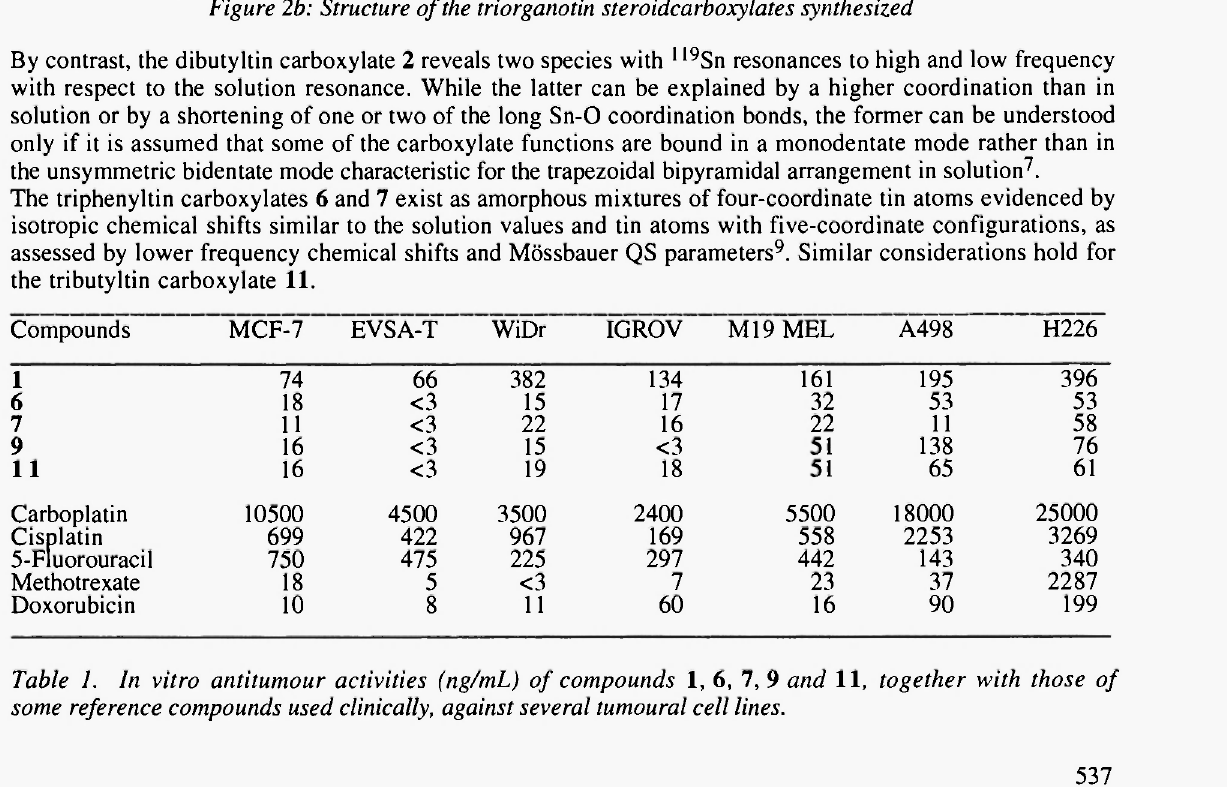
Table 1. In vitro antitumour activities (ng/mL) of compounds 1, 6, 7, 9 and 11, together with those of some reference compounds used clinically, against several tumoural cell